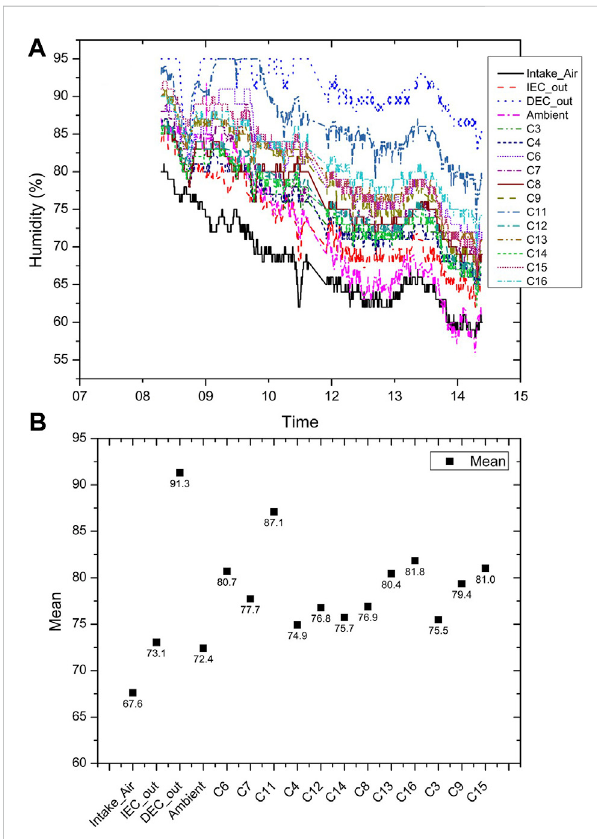
FIGURE 3 Measurementdataonrelativehumiditycapturedfrom (A) 0845 h until 1451 h and (B) corresponding mean values for the fi rst part of the